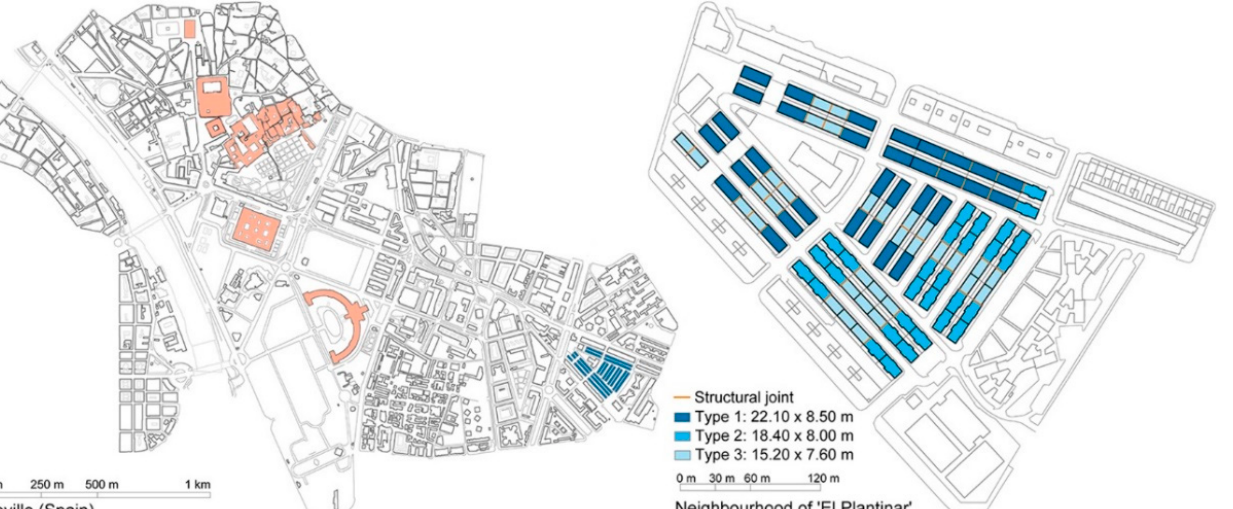
Figure 1. Flowchart of the work.